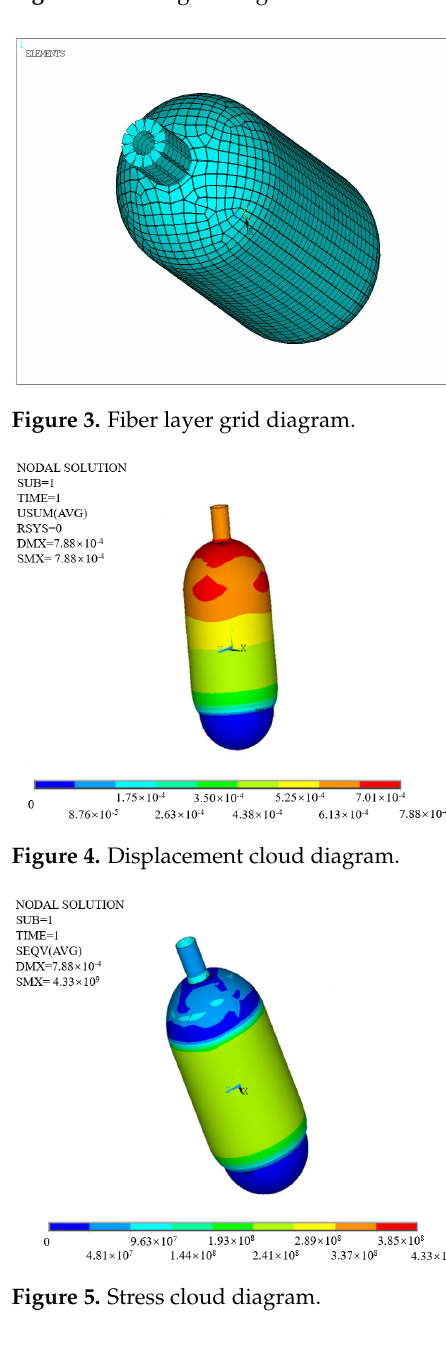
Figure 2. Model grid diagram.